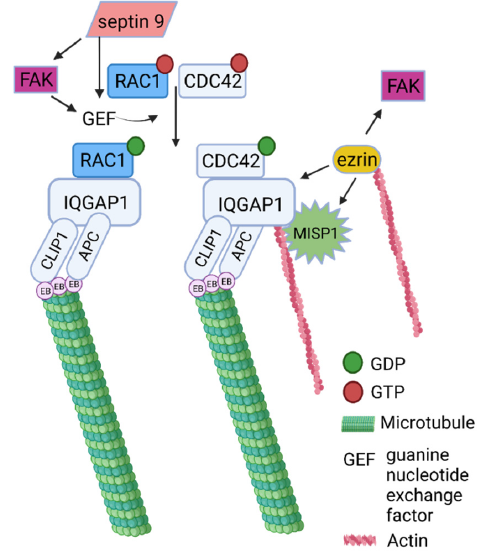
Figure 7. Suggested pathway involving five proteins found at the intersections of FA, MT and actin filament datasets. The hypothetical mechanism involves RAC1, septin 9, FAK, ezrin and MISP depicted together with common interacting partners.